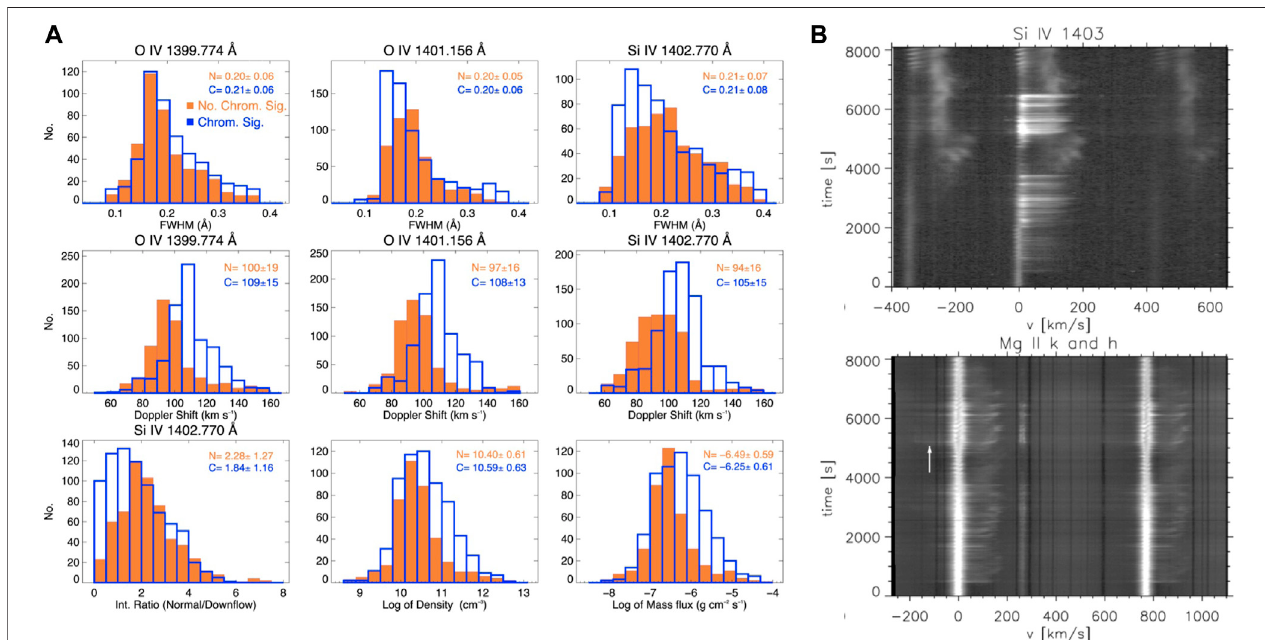
FIGURE 16 | IRIS observations of supersonic down fl ows over active regions. (A) Statistics of observed supersonic down fl ows using 60 raster data from IRIS by Samanta et al. (2018) (Figure 9 of that paper © AAS. Reproduced with permission). The top and middle rows show, respectively, the FWHM and Doppler velocity distributions measured in the O IV doublet and Si IV lines. The bottom left panel shows the intensity ratio between the “ normal ” (background) component and the down fl ow (red-shifted) component in the Si IV spectra. The bottom middle and right panels show, respectively, the distribution of the densities (calculated through lineratios) andthemass fl ux (inlogscale). Ineach paneltheorange andblue histograms denote, respectively, down fl owswithoutand withchromosphericcomponents. Averagevalueswith1 σ valuesareprintedineachpanel. (B) Temporalevolutionof IRIS spectraintheSiIV1403andOIV1401lines(top)andMgIIkandhlinesatabright dot withinan umbra, exhibiting supersonic down fl ows, reported byKleintet al.(2014) (Figure3ofthatpaper ©AAS. Reproduced withpermission). Noticetheexistence ofbursty(20 stimescale)andsteadypro fi les,particularlyintheMgIIandSiIVlines,respectively.Noticealsotheexistenceofsimultaneous,weakerup fl ows(indicatedby the